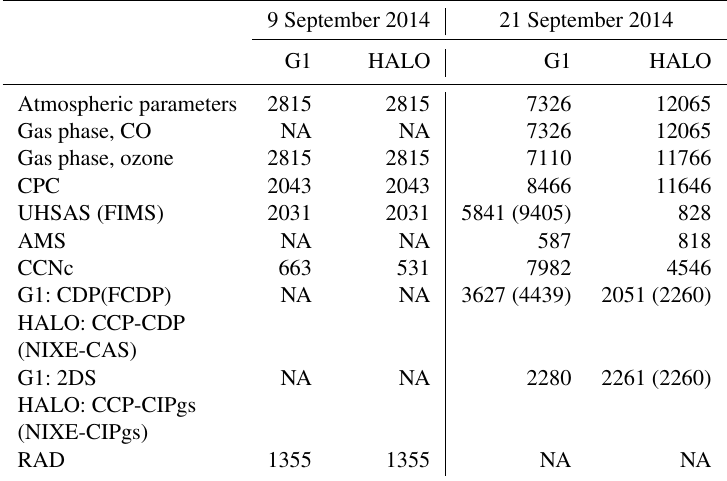
Table 2. Summary of the total data points compared between the G1 and HALO instruments. NA – not available.